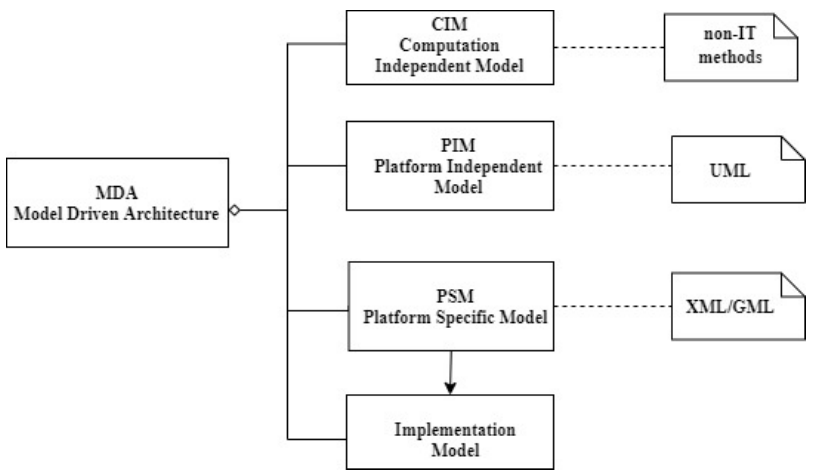
Figure 2. Data modelling. Source: own study.